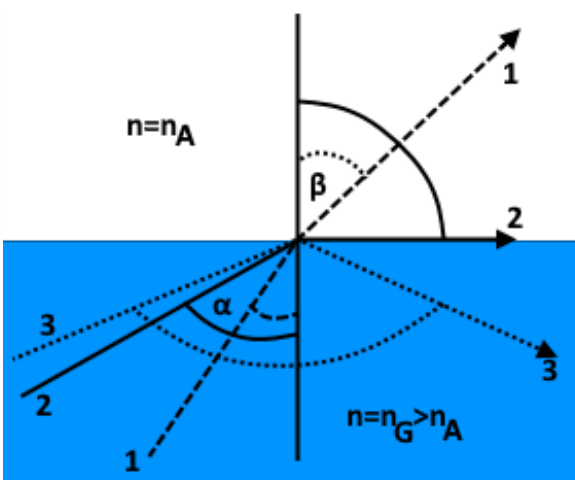
Figure 6. Total internal reflection phenomena